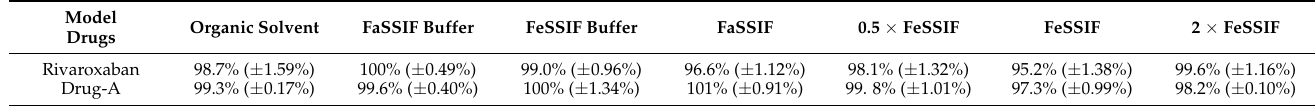
Table 3. Recoveries of compounds from corresponding precipitates. ( n =